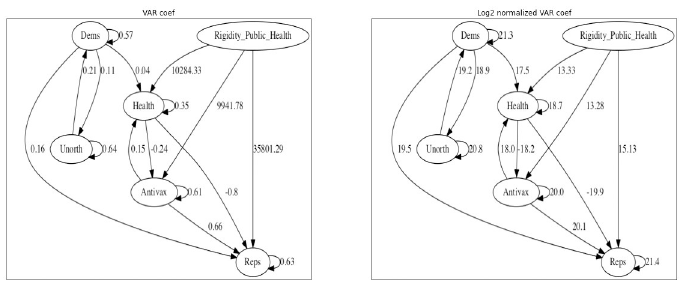
Fig 9. Left: significant VAR coefficients for a model incorporating public health measure. Right: log-normalized influence.